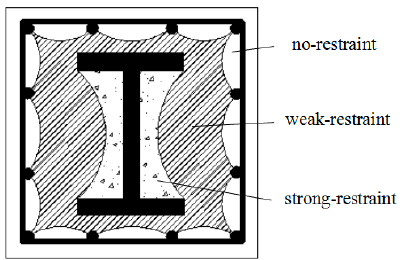
Figure 7. Section divisions of composite column.